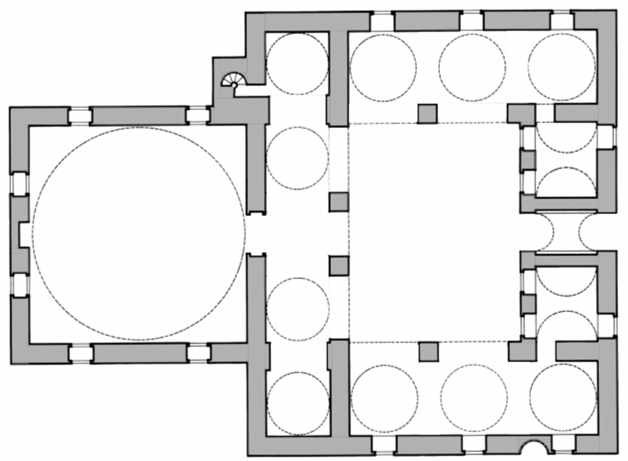
Figure 2. Plan layout of a typical single-unit mosque provided with a courtyard. Basci Ibrahim in Bursa.